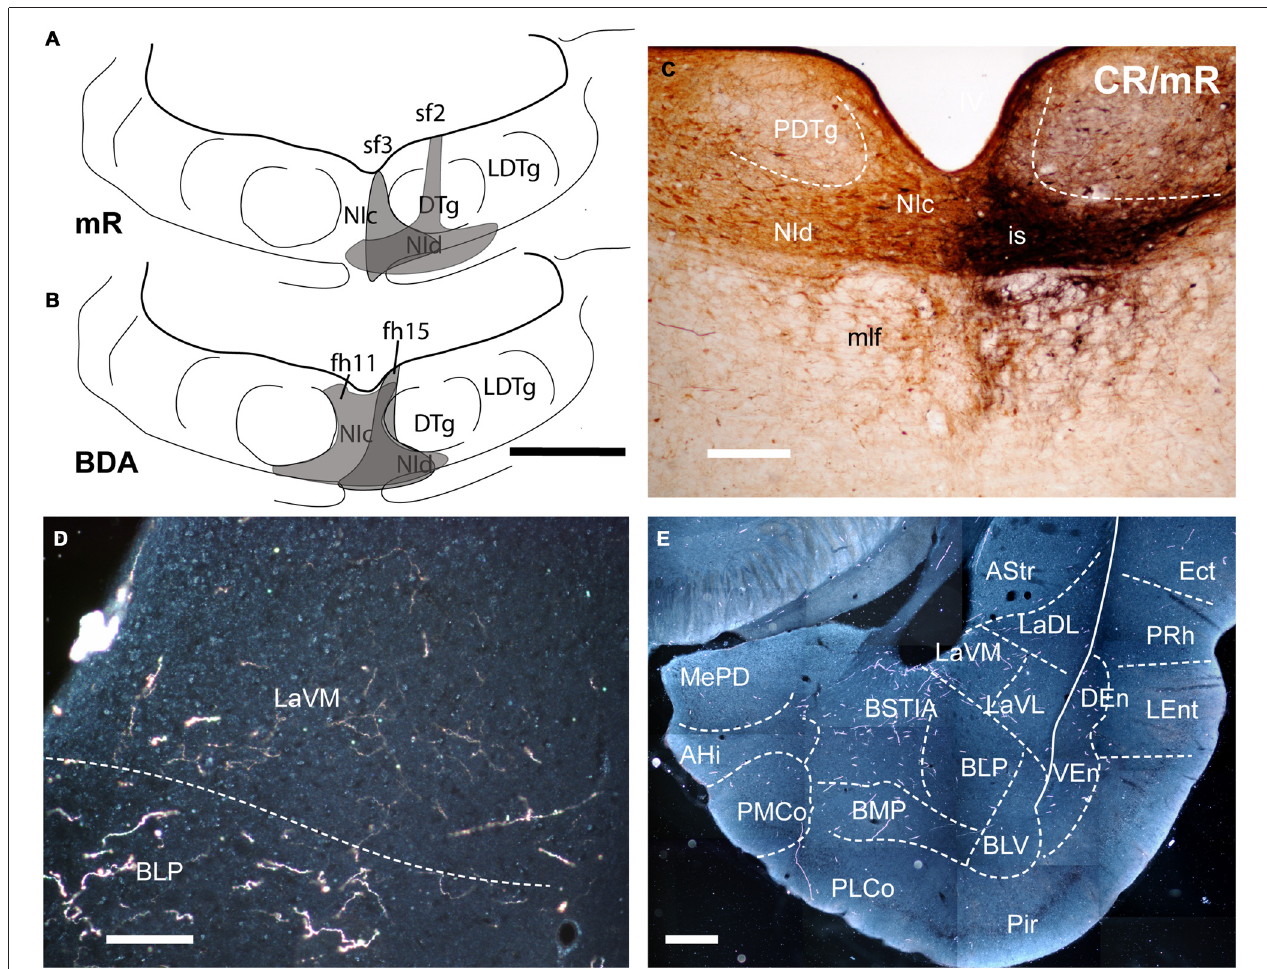
FIGURE 1 | Injection of an anterograde tracers, into the nucleus incertus (NI) and its transport to the amygdala. (A) Miniruby (mR) injection sites in the NI of cases sf2 and sf3. (B) Biotinylated dextran amine (BDA) injection sites in the NI in cases fh11 and fh15). (C) Site of mR injection in the NI of case sf2. (D) A darkfield image of the anterograde labeling in the ventromedial subnucleus of the lateral amygdala (LaVM) following a BDA injection into the NI (case fh11). (E) A collage of darkfield images of anterogradely-labeled fibers in amygdala at a mid-caudal level. Dense NI projections were present in the intra-amygdala part of the stria terminalis (STIA) and LaVM (case fh11). Calibration bars, 500 µ m (A,B) , 100 µ m (C) , 200 µ m (D,E)